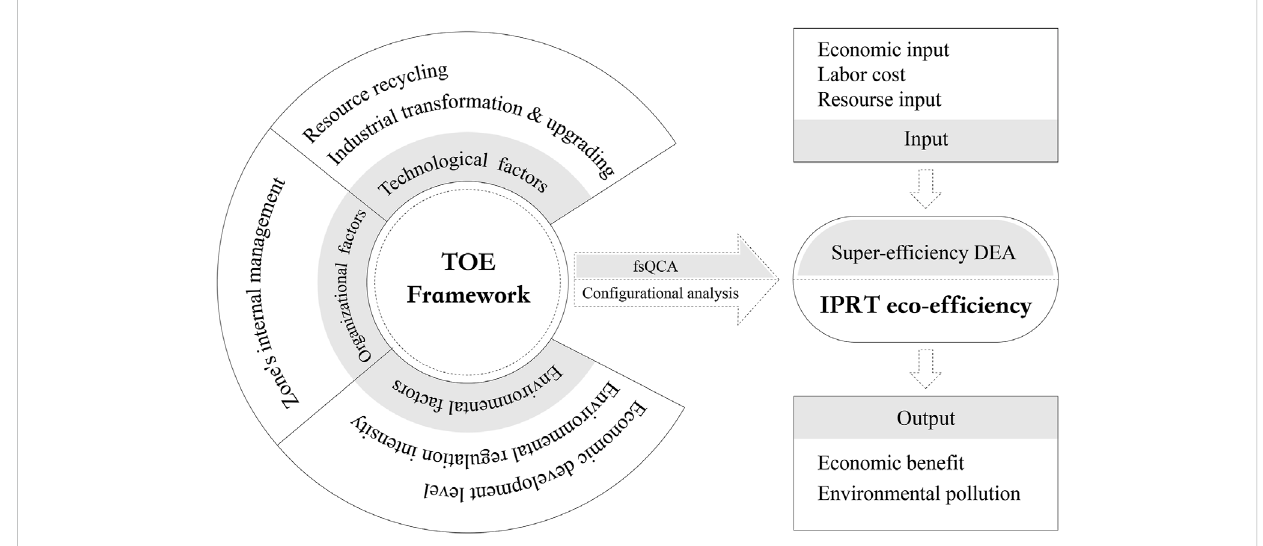
FIGURE 1 Research process of the